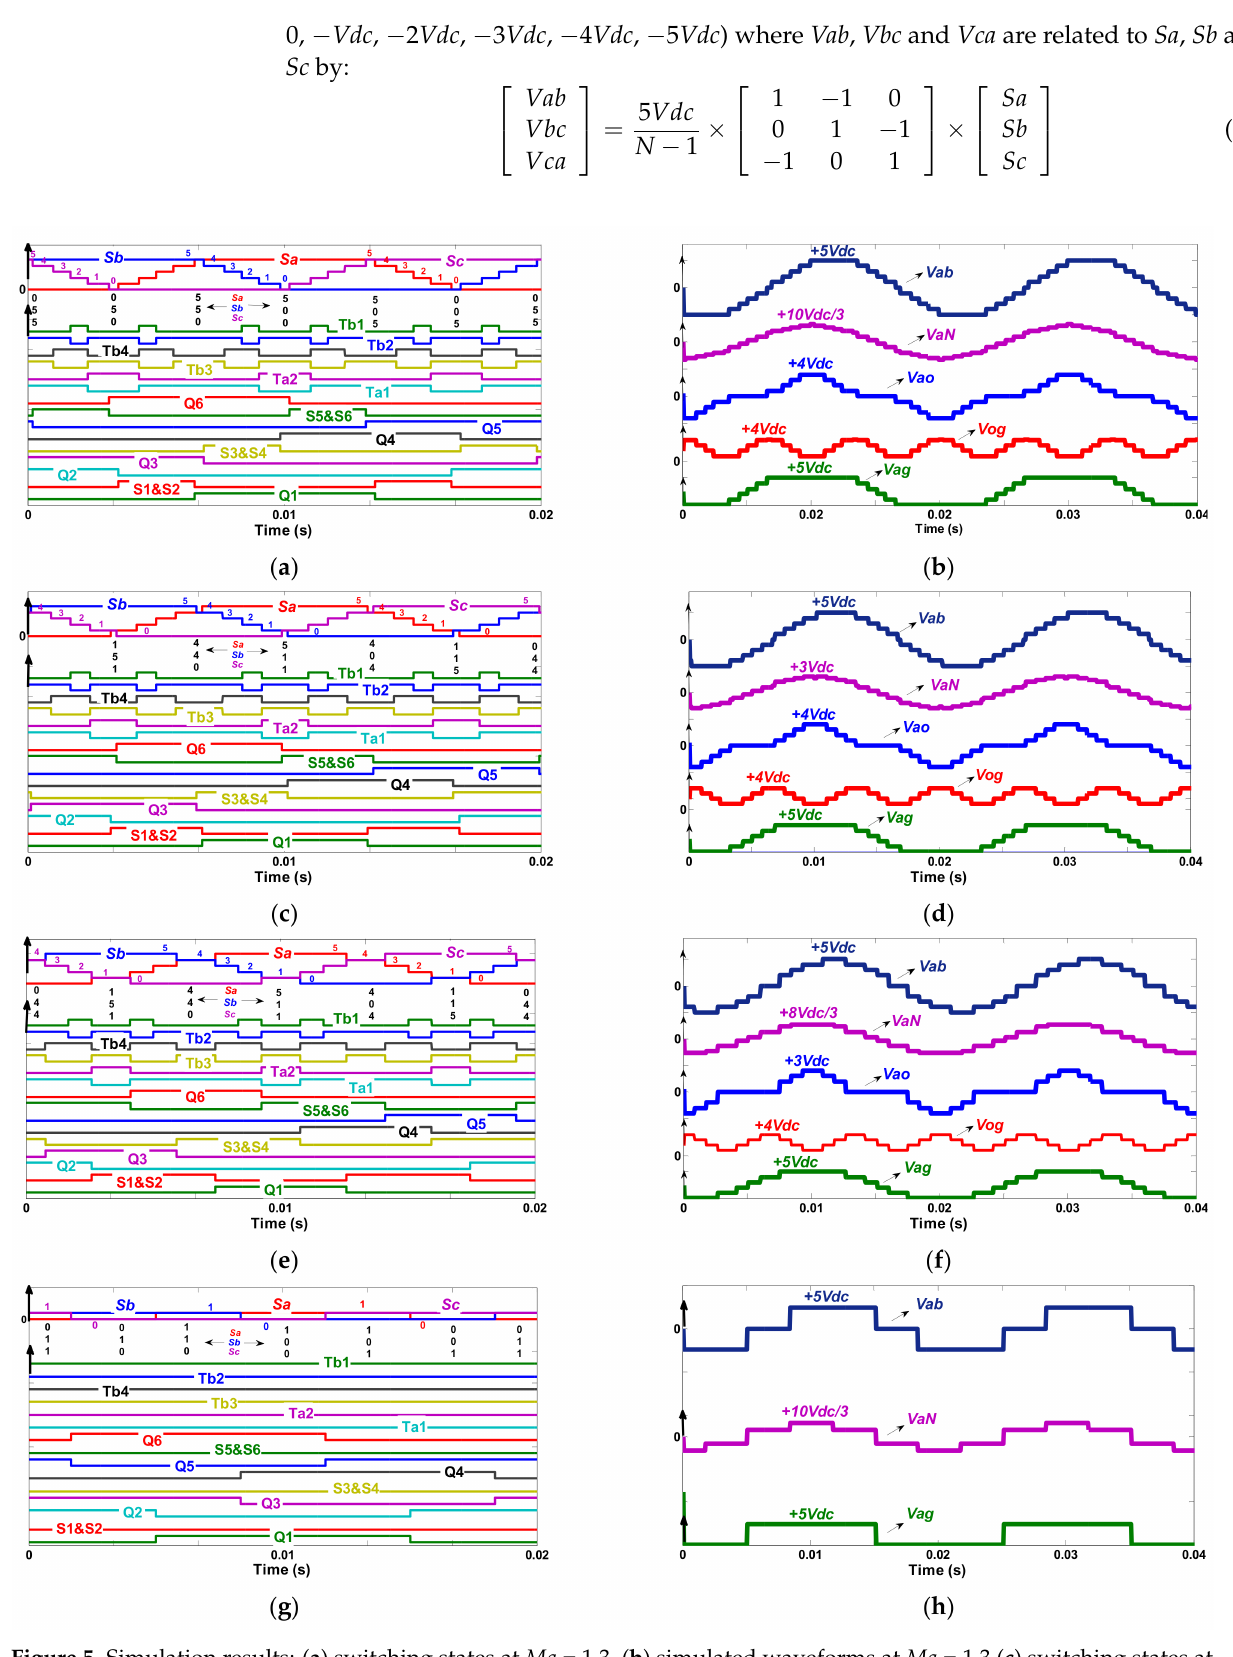
Figure 5. Simulation results: ( a ) switching states at Ma = 1.3, ( b ) simulated waveforms at Ma = 1.3 ( c ) switching states at Ma = 1.15, ( d ) simulated waveforms at Ma = 1.15, ( e ) switching states at Ma = 0.98, ( f ) simulated waveforms at Ma = 0.98, ( g ) switching states at Ma = 0.8 and ( h ) simulated waveforms Ma =